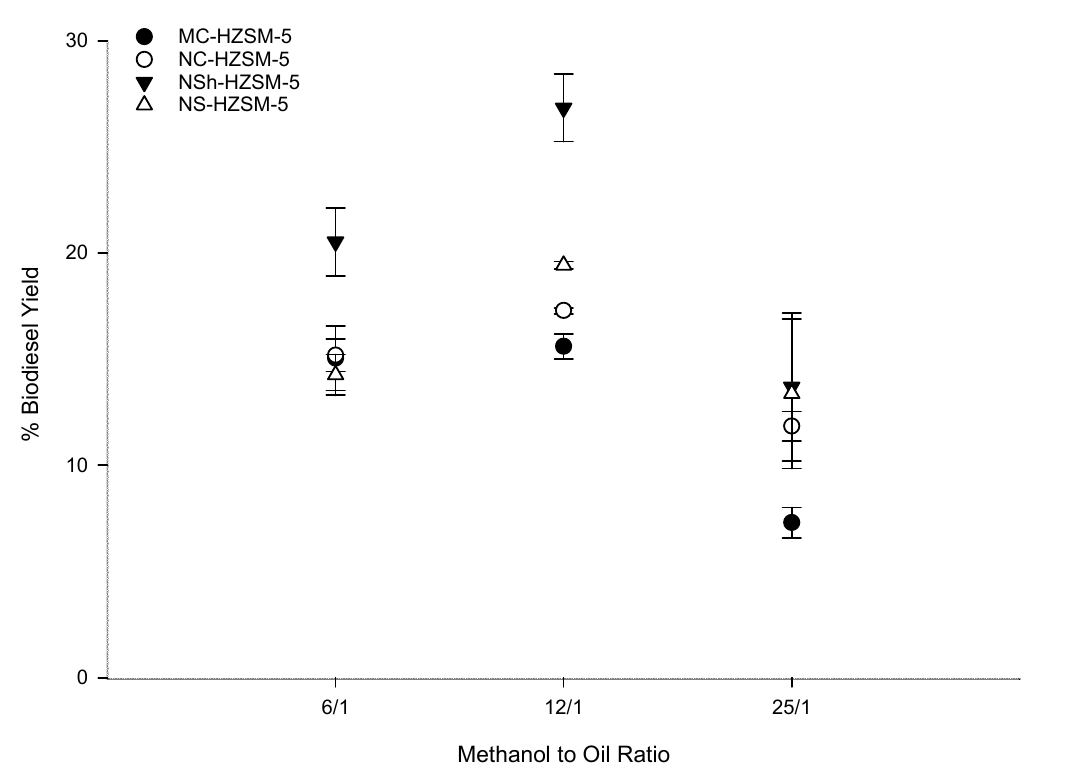
Figure 7 . Effect of methanol to WFO molar ration variation on the transesterification of WFO using MC ‐ HZSM5, NC ‐ HZSM5, NSh ‐ HZSM5, and NS ‐ HZSM5 catalysts, at 10 wt % catalyst loading, 140 °C, 550 rpm, and 6 h .